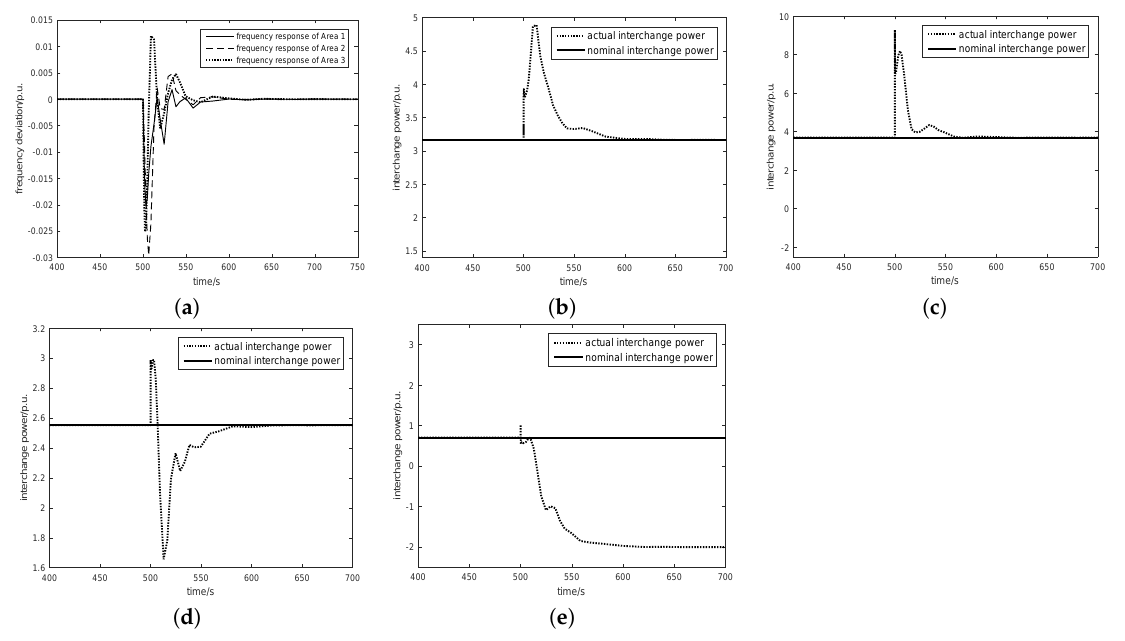
Figure 11. Simulation results in Section 5.3 (Condition (7) does not hold). ( a ) Frequency response of three areas; ( b ) interchange power between Areas 1 and 2; ( c ) interchange power between Areas 2 and 3; ( d ) interchange power between Areas 3 and 1; and ( e ) interchange power between two sub-areas in Area